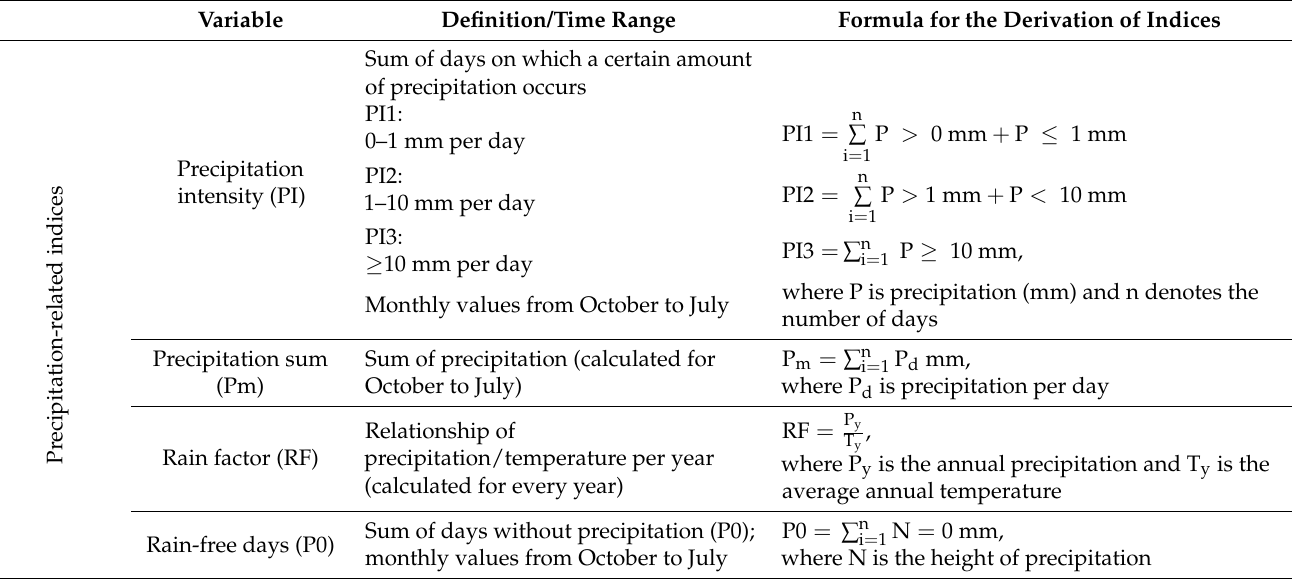
Table 3. Overview of the climate variables used in this